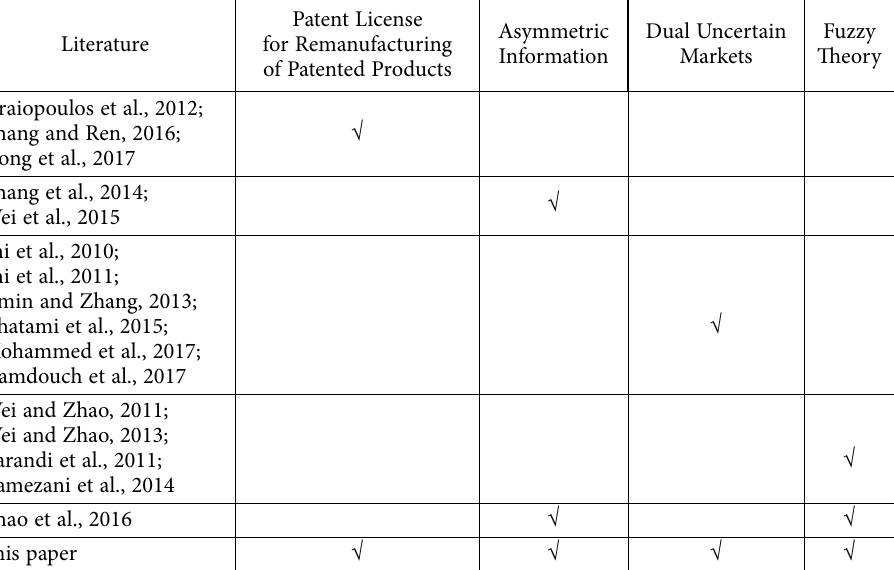
Table 1. A summary of differences between this study and the previous